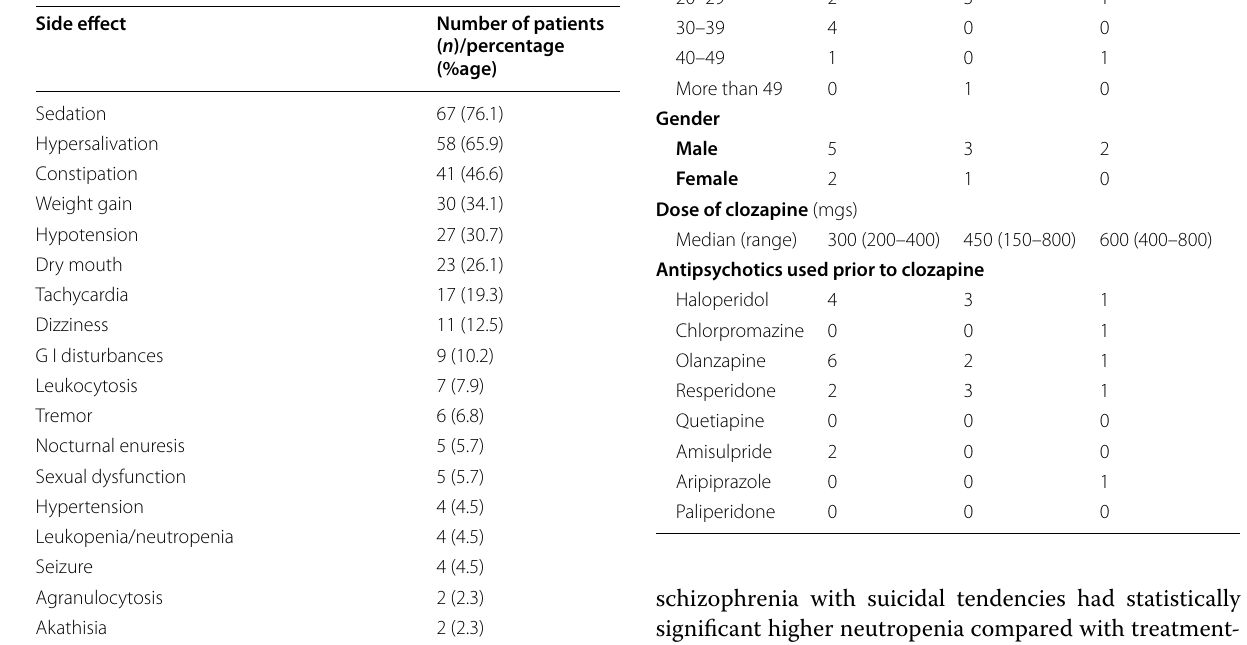
Table 4 Side effect profile of patients on clozapine